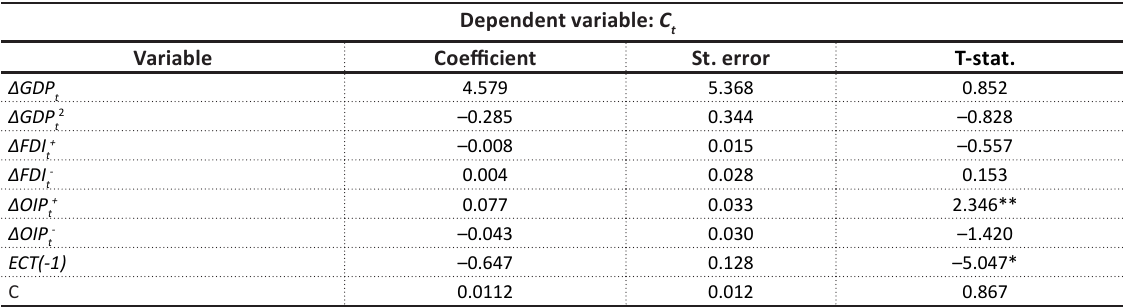
Table 7. NARDL model short-run results